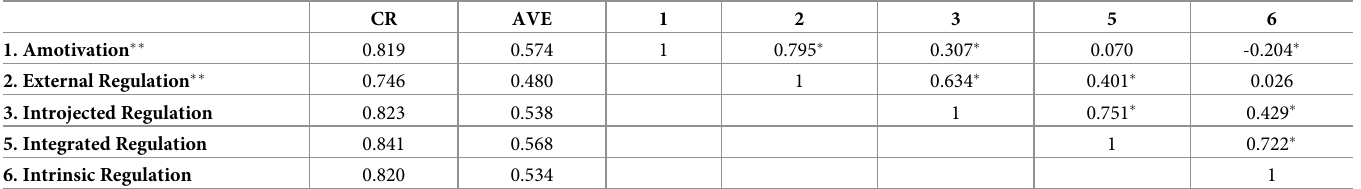
Table 4. CR, AVE, and standardised factor covariance for the final five-factor model of BREQ-3M. CR